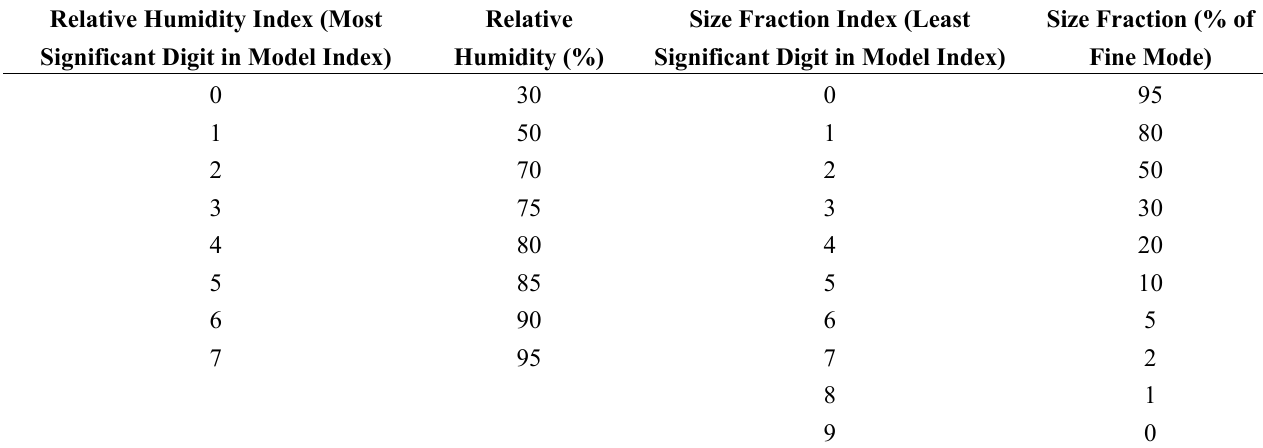
Table 1. Relative humidity and size fraction percentages and corresponding model index, models ranging from 0 to